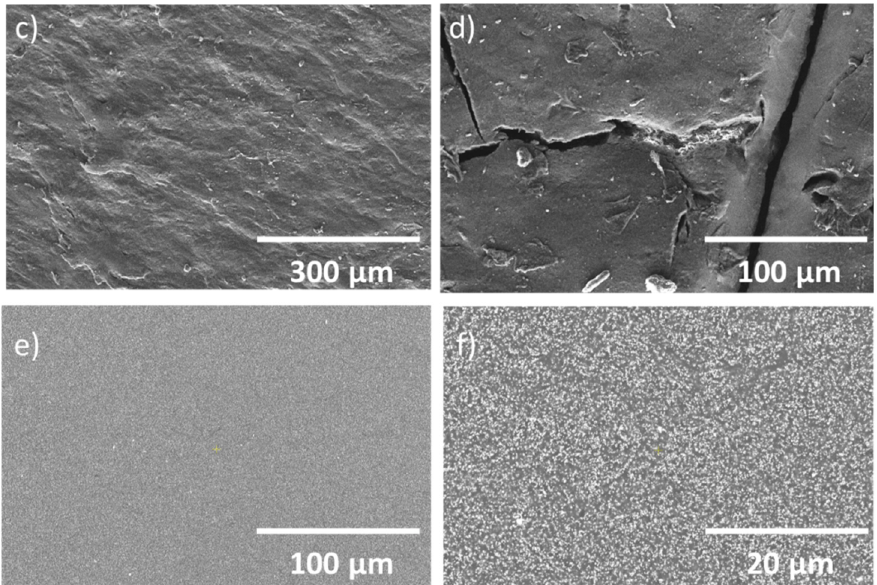
Figure 5. Top view SEM images for the sol-gel coating at 500 × magnification ( a ) and at 1000 × magnification ( b ), for the silicone spray coating composed of 5% Al 2 O 3 in weight at 180 × magnification ( c ) and at 450 × magnification ( d ), and for the electrostatic spray coating at 1000 × magnification ( e ) and at 5000 × magnification ( f ), respectively.